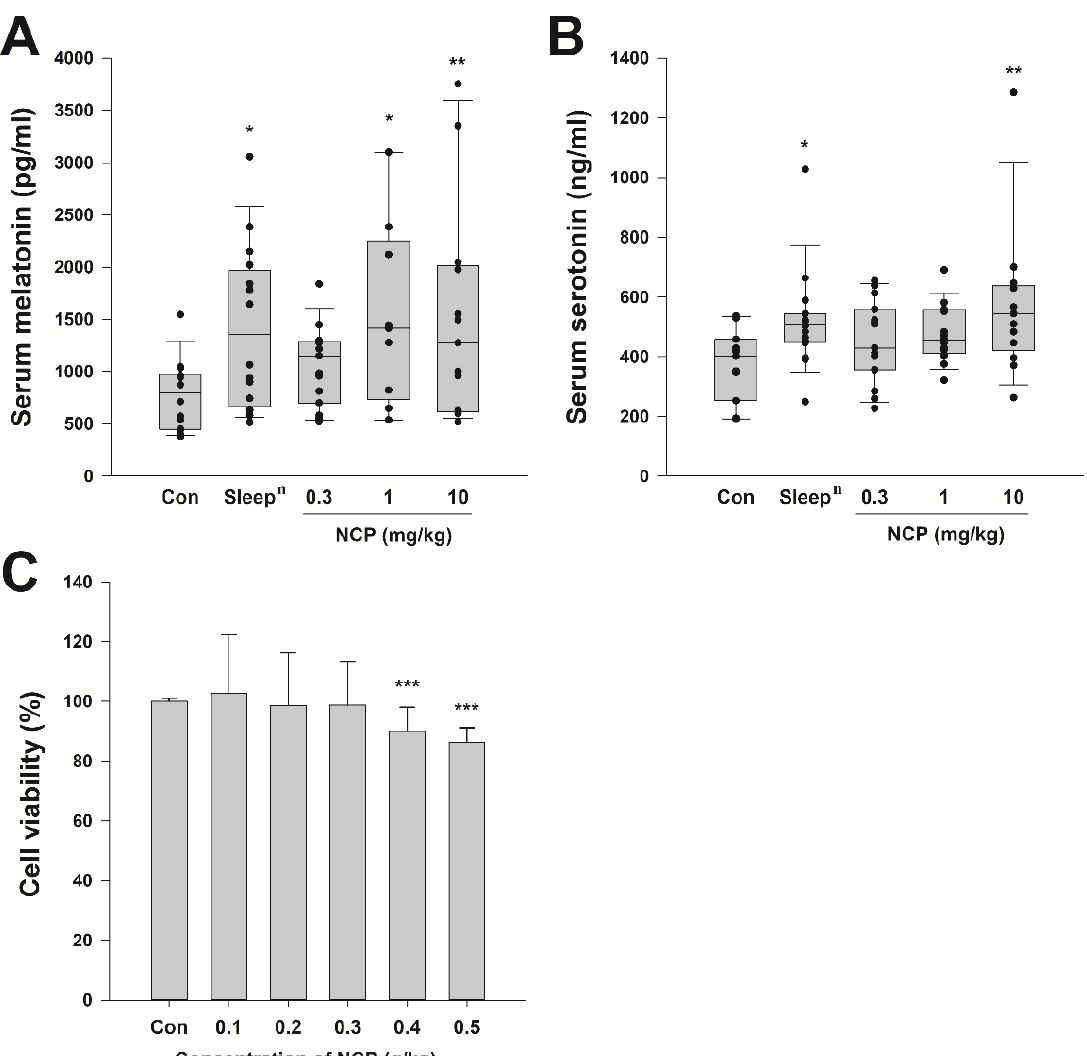
Figure 4. Sleep factor blood test in mice according to NCP intake and toxic concentration in cells. Serum melatonin levels ( A ) and serum serotonin levels ( B ) in mice when NCP was ingested by con- centration. A toxicity test result of NCP using Raw 264.7 ( C ). All data were verified for significance through one-way ANOVA and post-test by Fisher-LSD method to obtain significance between groups. *** p < 0.001, ** p < 0.01, * p < 0.05.